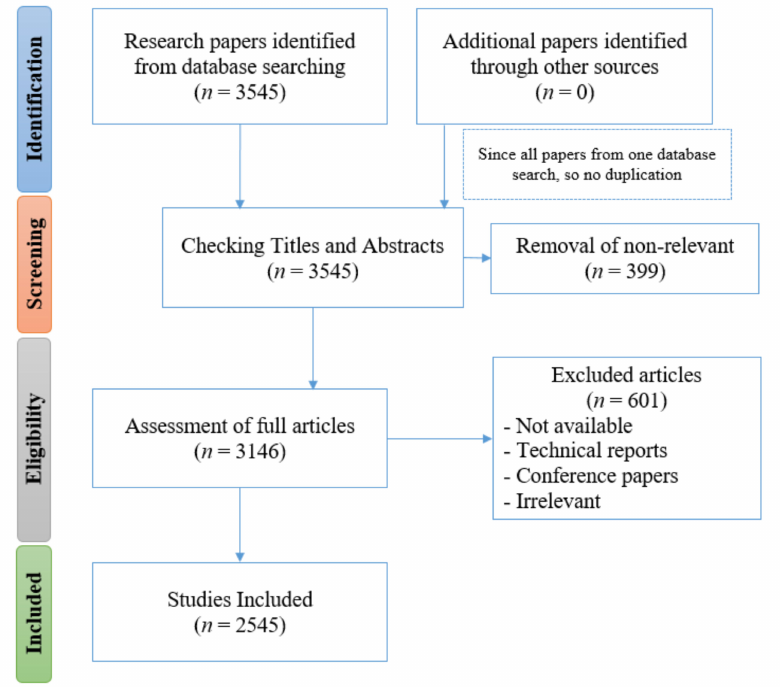
Figure 1. PRISMA flowchart for quantitative analysis